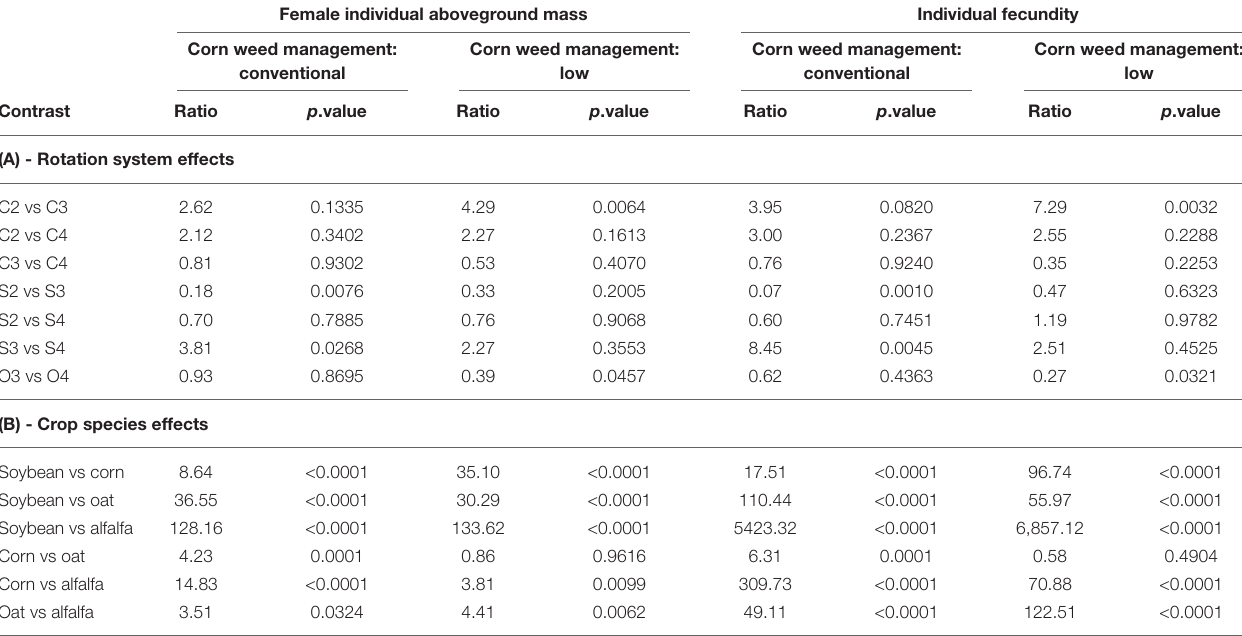
TABLE 7 | Rotation system and crop species effects on individual female aboveground mass and